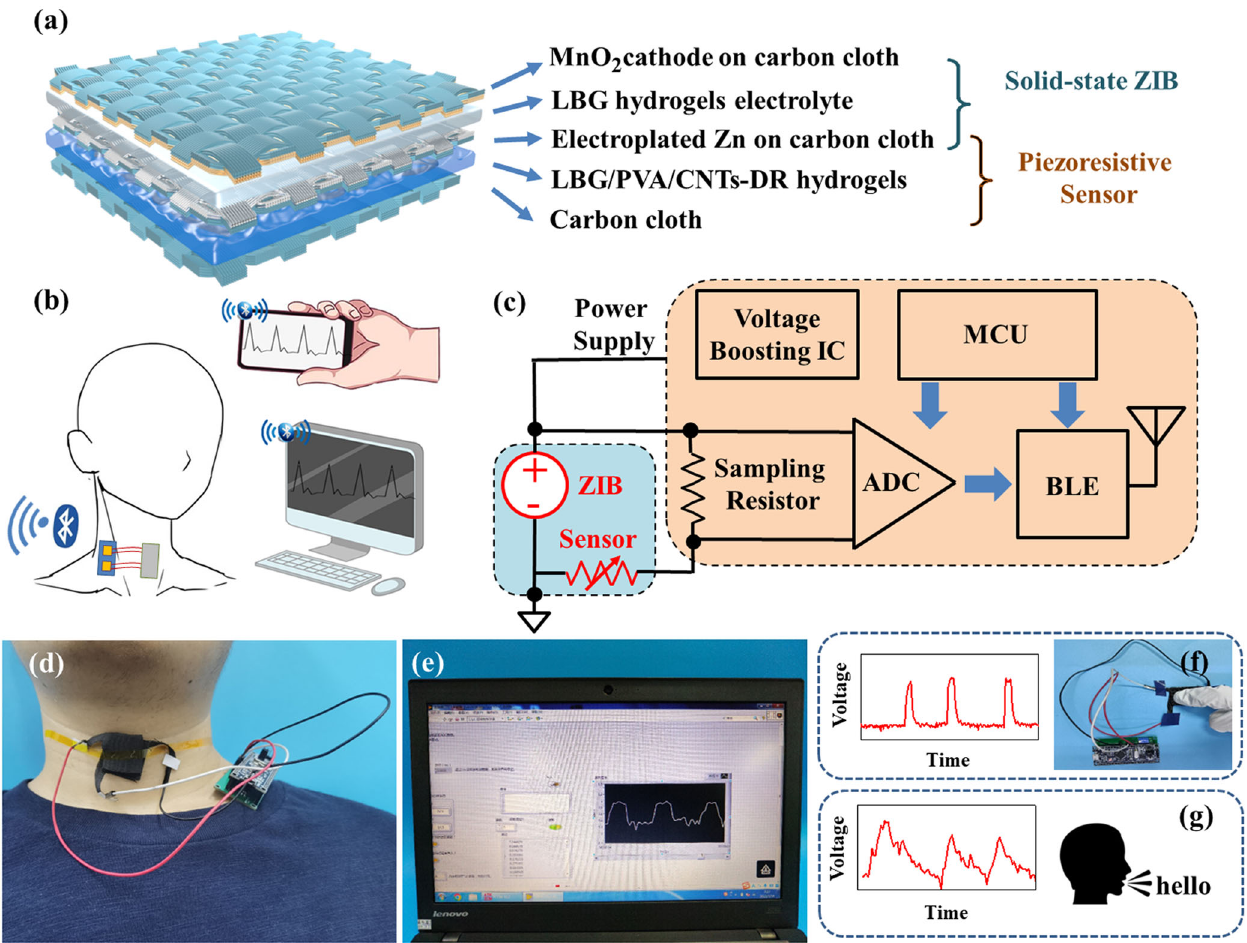
Fig. 5 The monolithic integration of the sensor with LBG/PVA/CNTs-DR hydrogel and fl exible ZIB. a Schematic illustrations of the active powering senser integrated with a solid-state ZIB in the layer-by-layer view. b Schematic illustrations of the active powering senser with a solid- state ZIB and a signal management circuit system mounted on the throat to monitor pronunciation. c A simpli fi ed circuit diagram of the active powering senser with a solid-state ZIB and a homemade signal management circuit system. d Photograph of the active powering senser with a solid-state ZIB and a homemade signal management circuit system mounted on the throat to monitor pronunciation. e Photograph showing that the real-time pronunciation monitoring measurement signal can be wireless transmitted by a Bluetooth device and displayed on a computer via a custom interface. Detection of the real-time pulse signals from ( f ) pressing and ( g ) speaking signals of the word